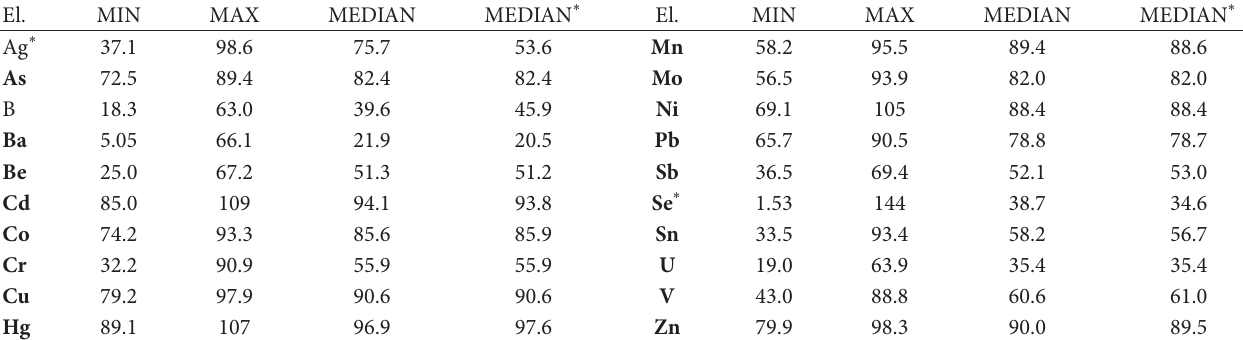
T 3: Median values of degree of extractability of aqua regia contents to real totals.